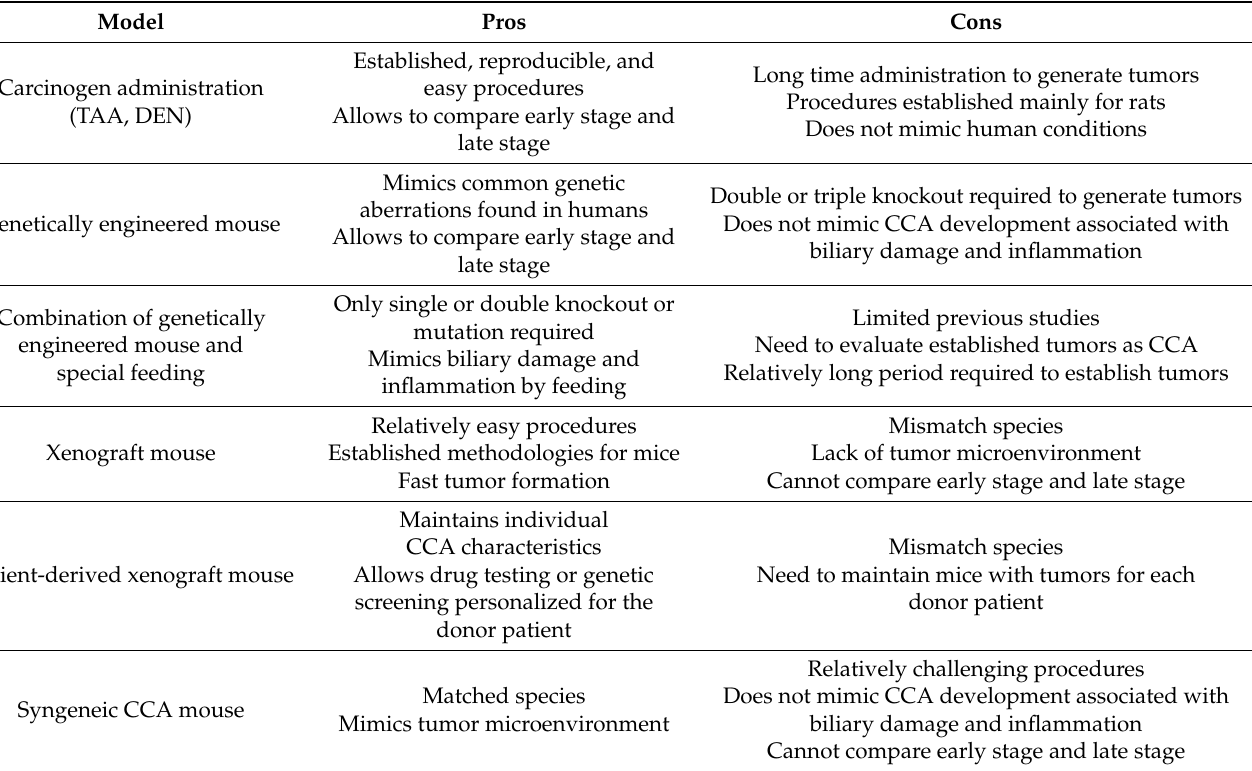
Table 2. Brief characteristics of current CCA animal